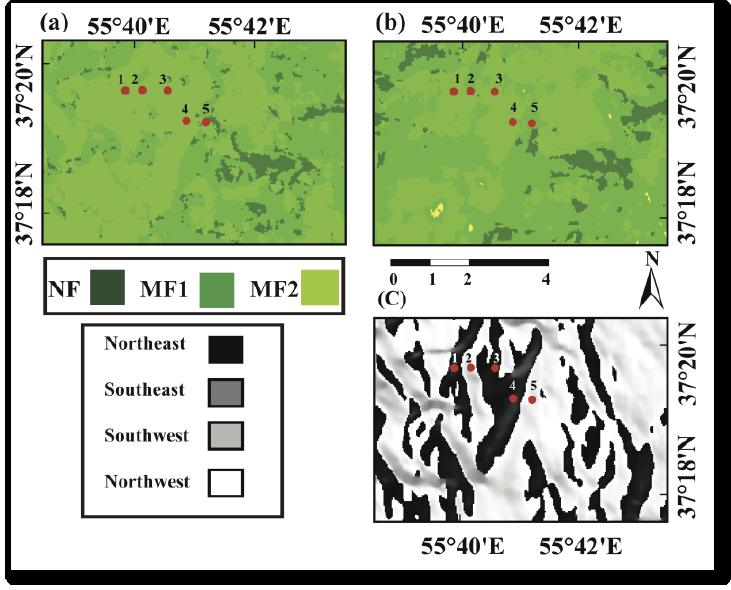
Figure 6. Comparison of classification accuracy resulted from SVM classifier for